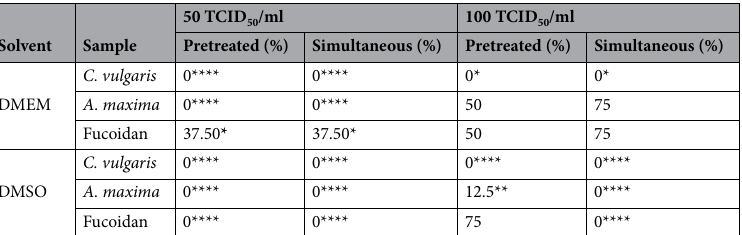
Table 1. Comparison in the percentage of infection (appearance of CPE) between 50 and 100 TCID 50 /ml. All assays were carried out with 8 replicates, except for the DMEM assay with 100 TCID 50 /ml which had 4 replicates. The results are given in percentage of infection (CPE appearance in the replicates). 1-way-ANOVA **** p value < 0.00001. **< 0.001 *< 0.01.